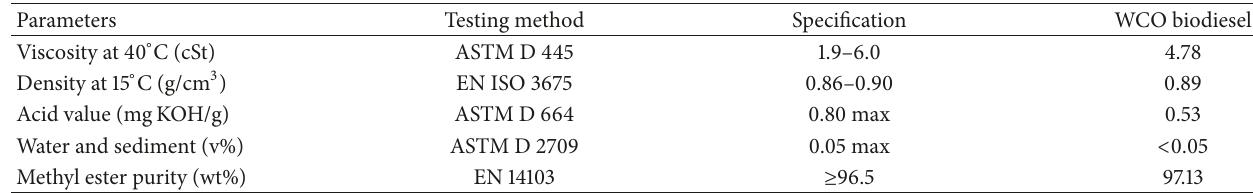
Table 8: Biodiesel